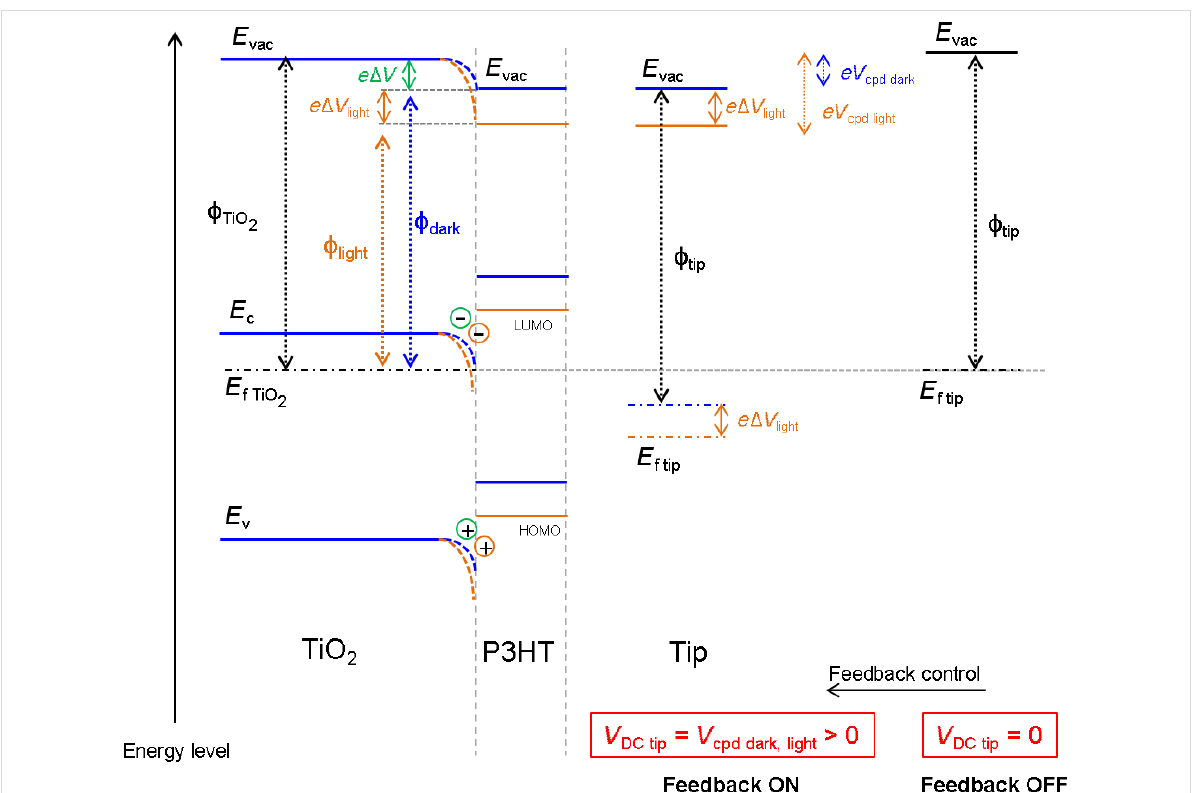
Figure 4: Schematic representation of the electronic band structure of the [TiO 2 /P3HT-COOH]–[tip] system , in the KPFM measurement configuration considering no feedback control (right part) and feedback control (left part). The blue (orange) lines correspond to the situation in the dark (under illu- mination). e Δ V (green color) represents the bond dipole in the dark, while e Δ V light (orange color) represents the photovoltage under illumination. E vac , E c , E v , E f and Φ stand for vacuum level, conduction band, valence band, Fermi level and workfunction, respectively. HOMO and LUMO mean highest occupied molecular orbital and lowest unoccupied molecular orbital,